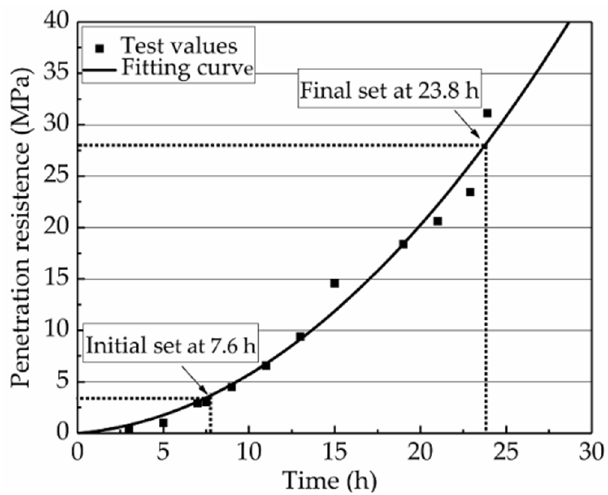
Figure 2. Results of the penetration test [29].